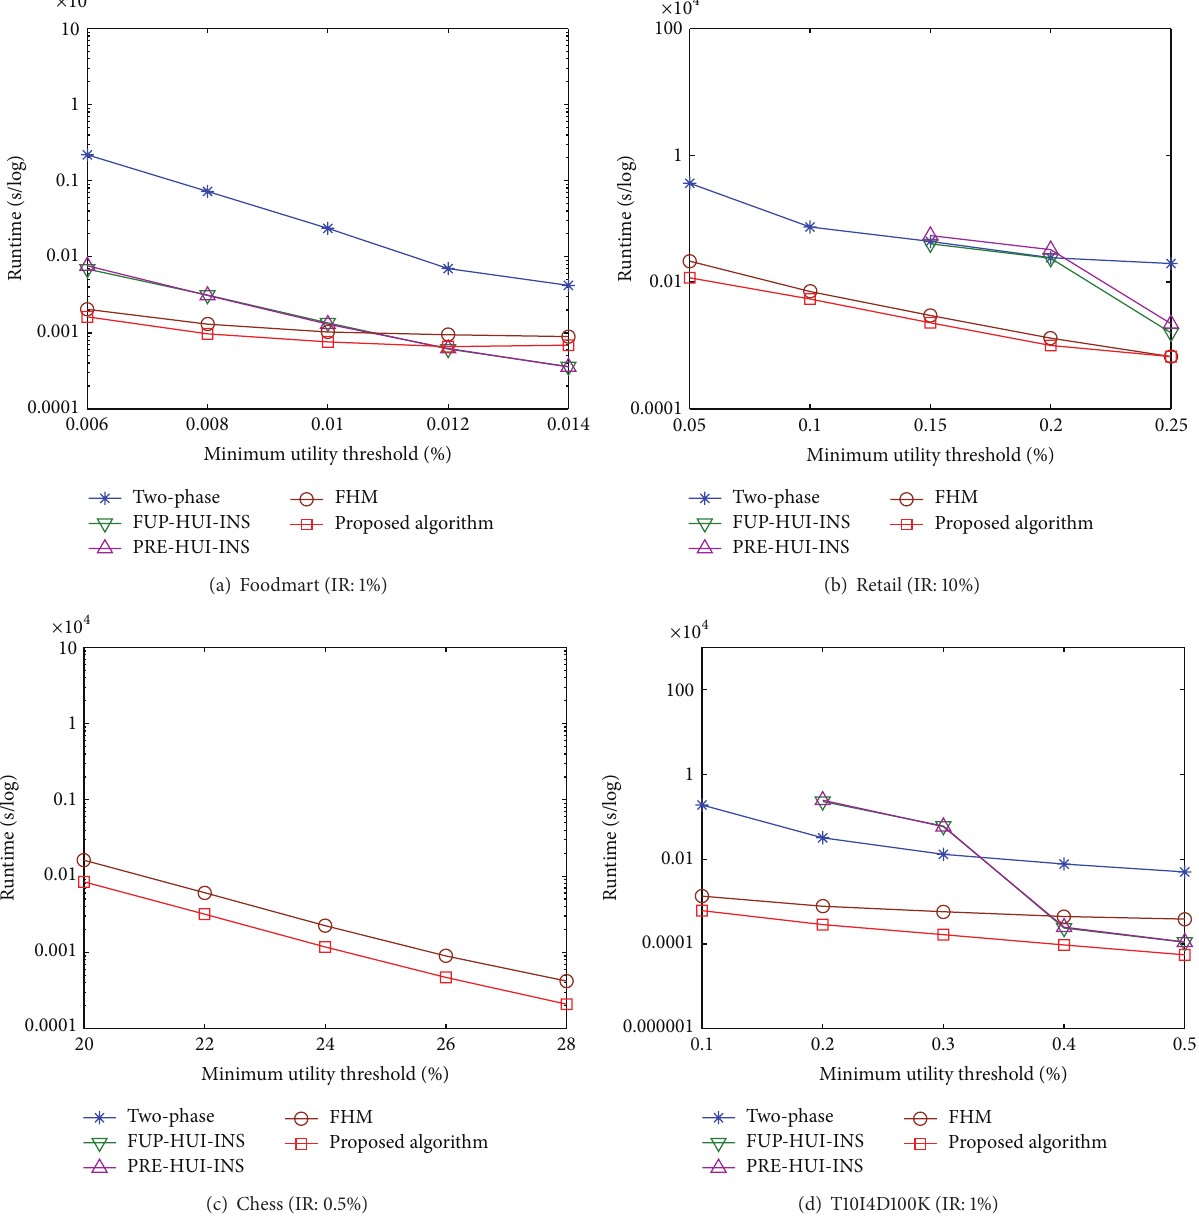
Figure 6: Runtime under various minimum utility